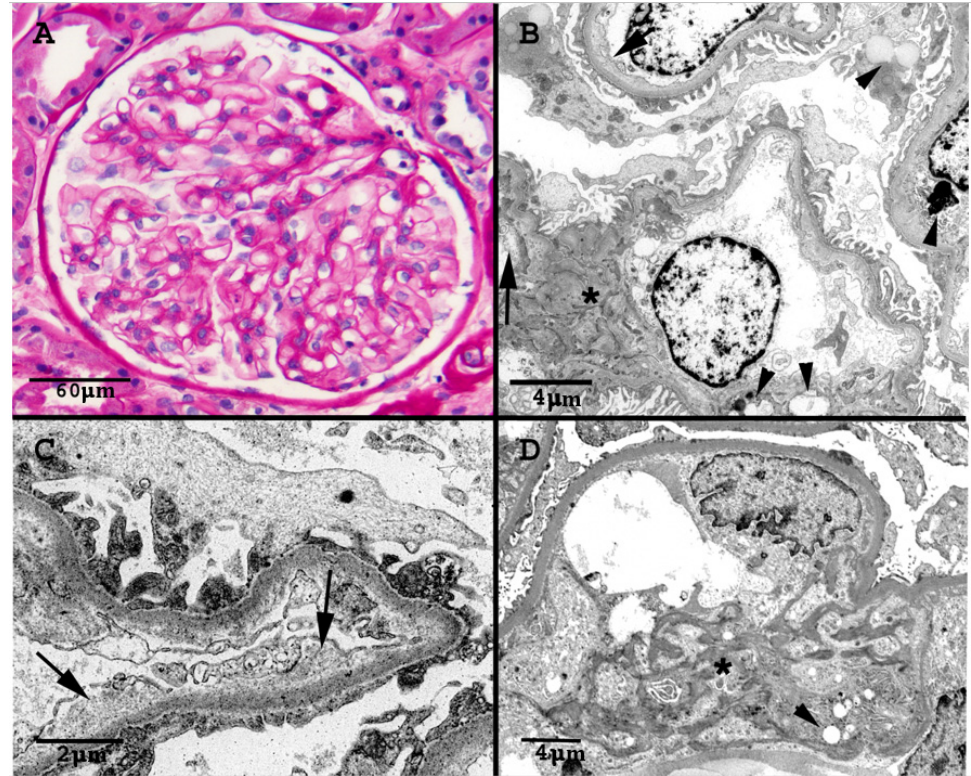
Figure 2. ( A ): Normocellular glomerulus with open capillary lumina and mildly expanded mesangium due to increase in matrix (PAS stain). ( B ): Electron micrograph of several capillary lumina. There is expansion of the lamina rara interna (arrows), and multiple lipid inclusions are noted (arrowheads). The mesangium is minimally accentuated (asterisk). ( C ): Electron micrograph demonstrating areas of prominent expansion of the subendothelial space with accumulation of electro-lucent granular material. ( D ): Electron micrograph highlights heterogeneous mesangial matrix (asterisk) with increased electron-dense mottled strands, admixed with loose more clear areas. Arrowhead marks lipid inclusions.